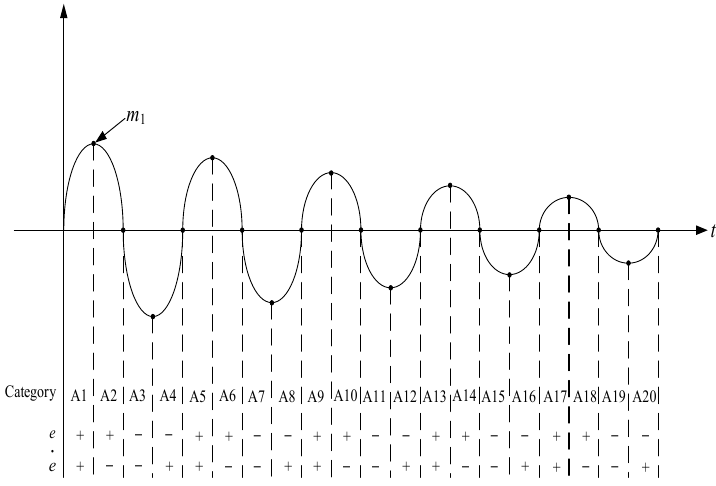
Figure 9. Dynamic analysis of the rotational speed difference and the rate of change in rotational speed difference for compressor. Table 2. Extension matter-element models of 20 categories and frequency variations ∆ Freq .